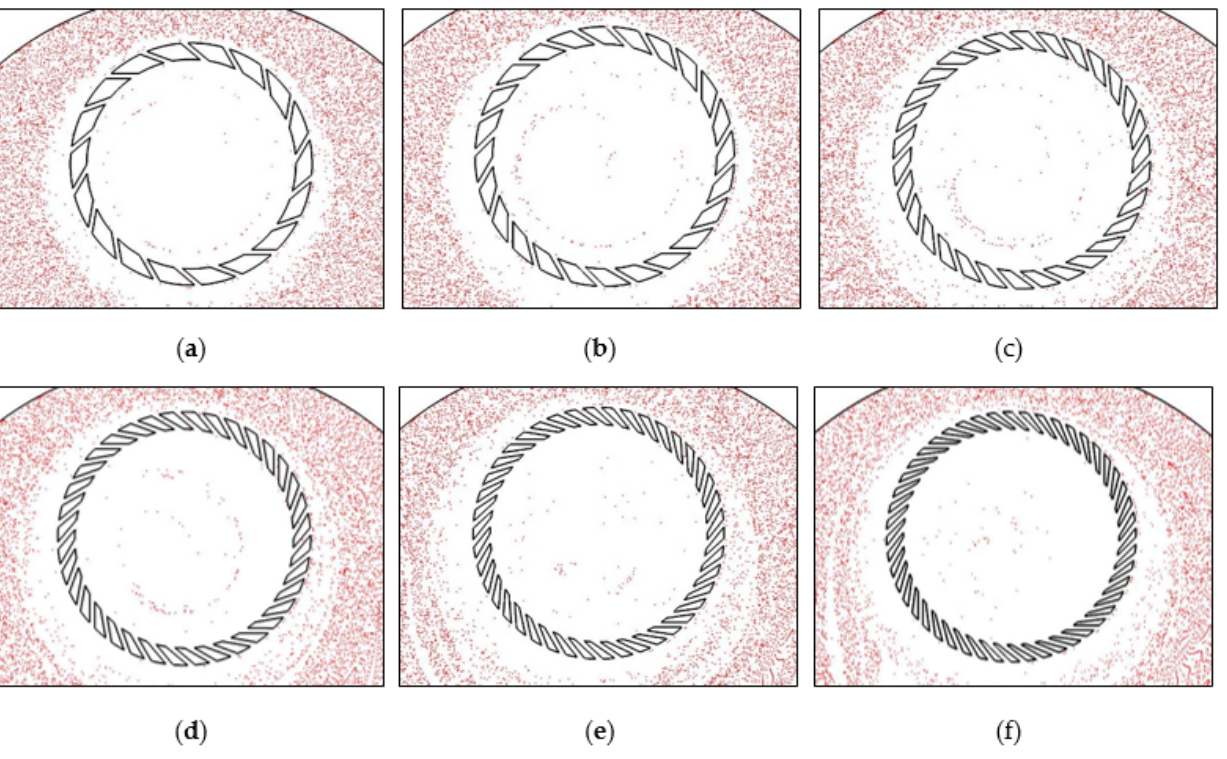
Figure 11. Abrasive distribution nephogram in polishing gap with different groove numbers: ( a ) 18, ( b ) 24, ( c ) 30, ( d ) 36, ( e ) 42, ( f ) 48.